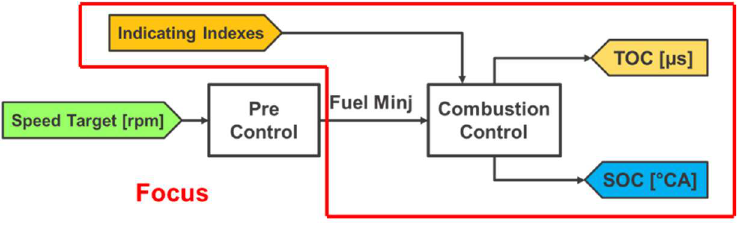
Figure 2. Connection between the pre-existing control (Pre-Control block) implemented inside the Liebherr ECU2-HD and the new control strategy (Combustion Control Block) based on the use of the combustion metrics.